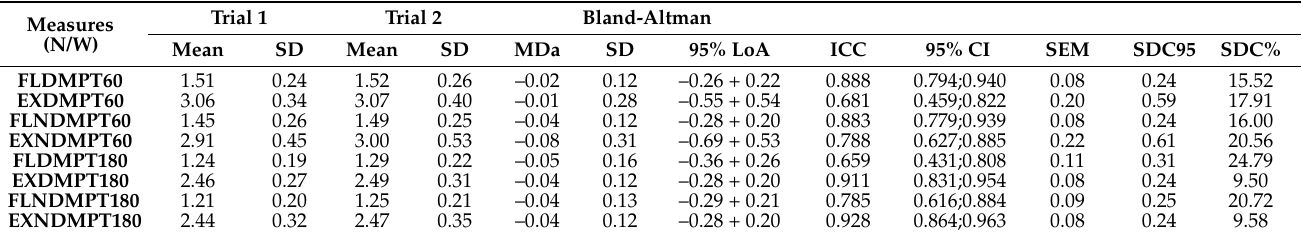
Table 3. Intra-rater reliability of the old dynamometer.